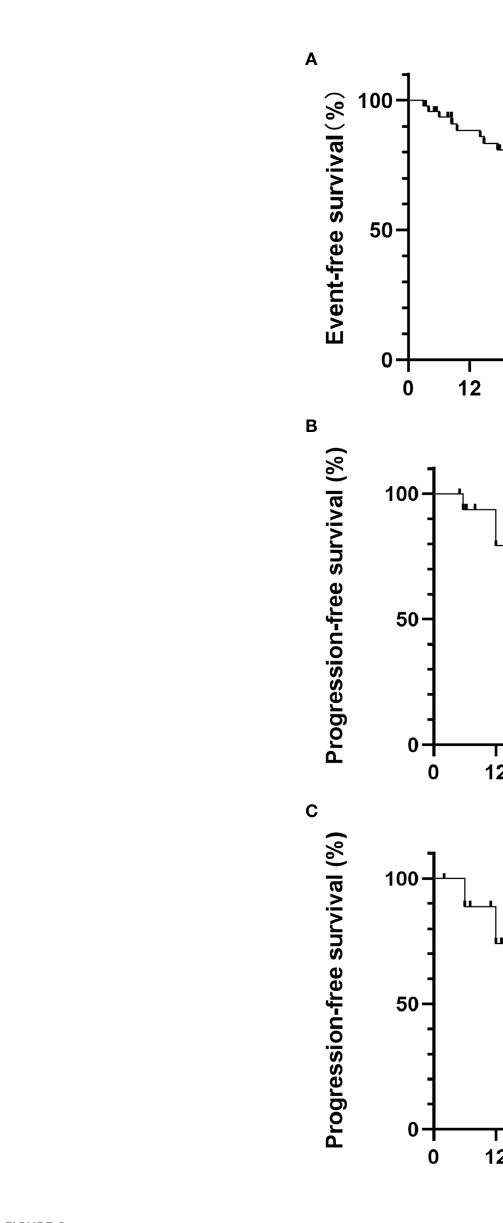
FIGURE 2 (A) Event-free survival of localized ASPS; (B) Progression-free survival for the observation group; (C) Progression-free survival for the PD-1 monotherapy